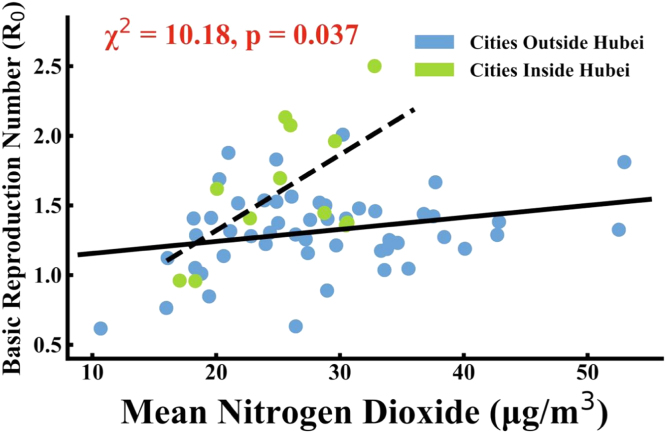
Nitrogen dioxide concentration and spreadability of COVID-19, divided by area. The basic reproductive number R0 was positively associated with NO2 (meta χ2 = 10.18, p = 0.037) in cities outside Hubei (blue points, 51 cities, r = 0.29, p = 0.046, solid line) and cities inside Hubei (green points, 12 cities, r = 0.51, p = 0.13, dashed line). We controlled the effects from temperature and relative humidity in the multiple linear regression models. (For interpretation of the references to color in this figure legend, the reader is referred to the web version of this article.)